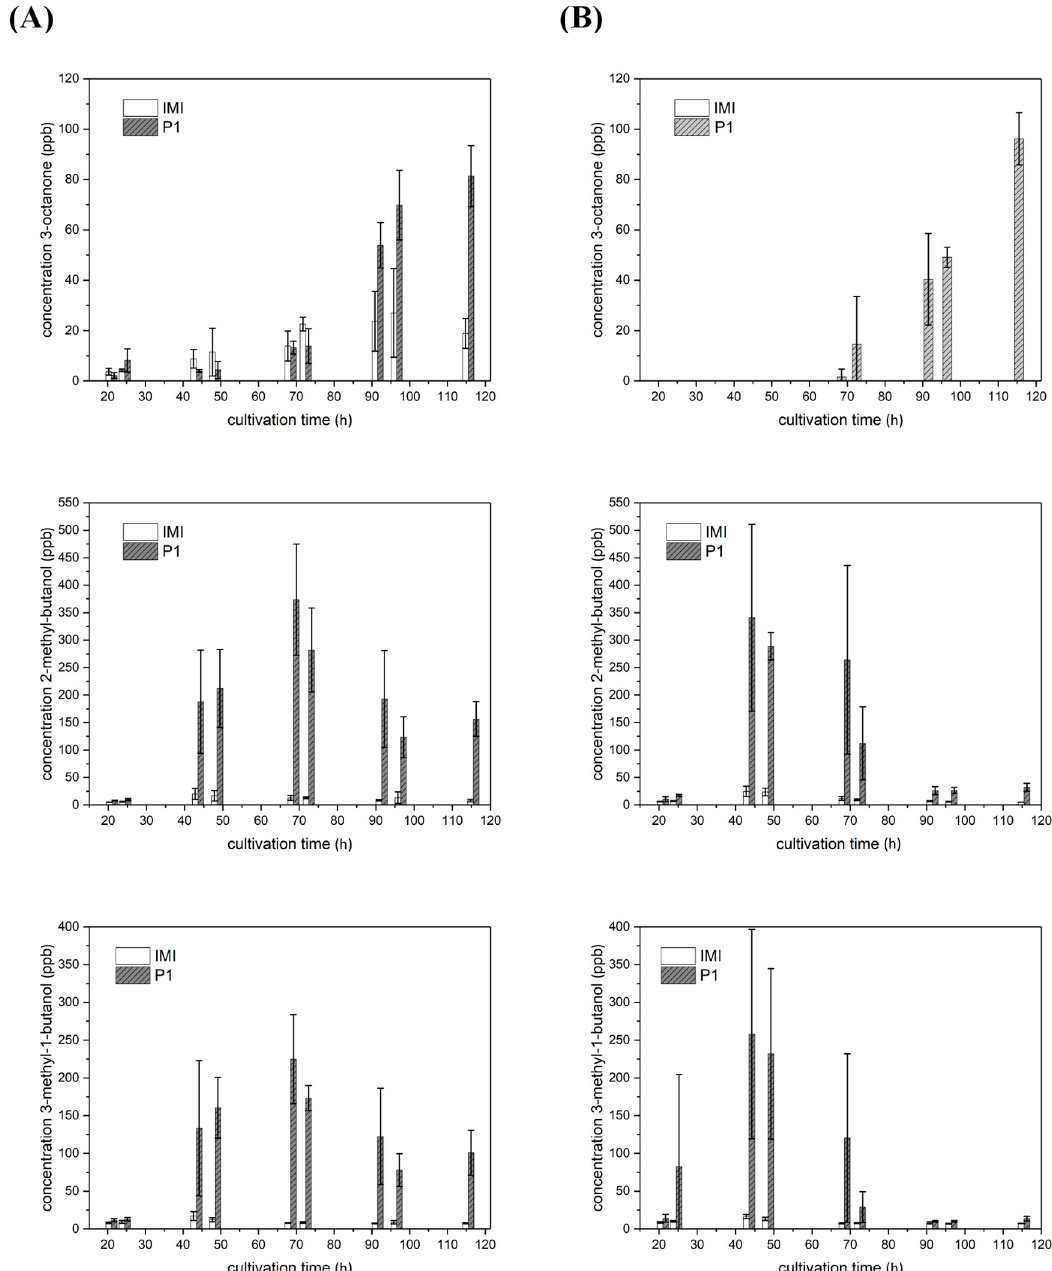
Figure 5. VOCs produced by T. atroviride P1 and IMI 206,040 in a strain-specific and light-dependent manner. Levels (ppb) of 3-octanone (row 1), 2-methyl-butanol (row 2), and 3-methyl-1-butanol (row 3) detected in the headspace of T. atroviride P1 (P1) and T. atroviride IMI 206040 (IMI) cultures grown on PDA in Schott bottles at 25 ◦ C under ( A ) light-dark conditions or ( B ) in complete darkness. GC–IMS measurements were conducted along a cultivation period of 120 h. Results shown are means ± SD ( n =